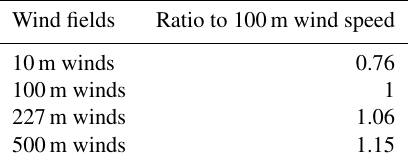
Table B1. Wind speeds at Dallas–Fort Worth for the April– September 2019 average at various vertical levels in comparison to the 100m wind speed.